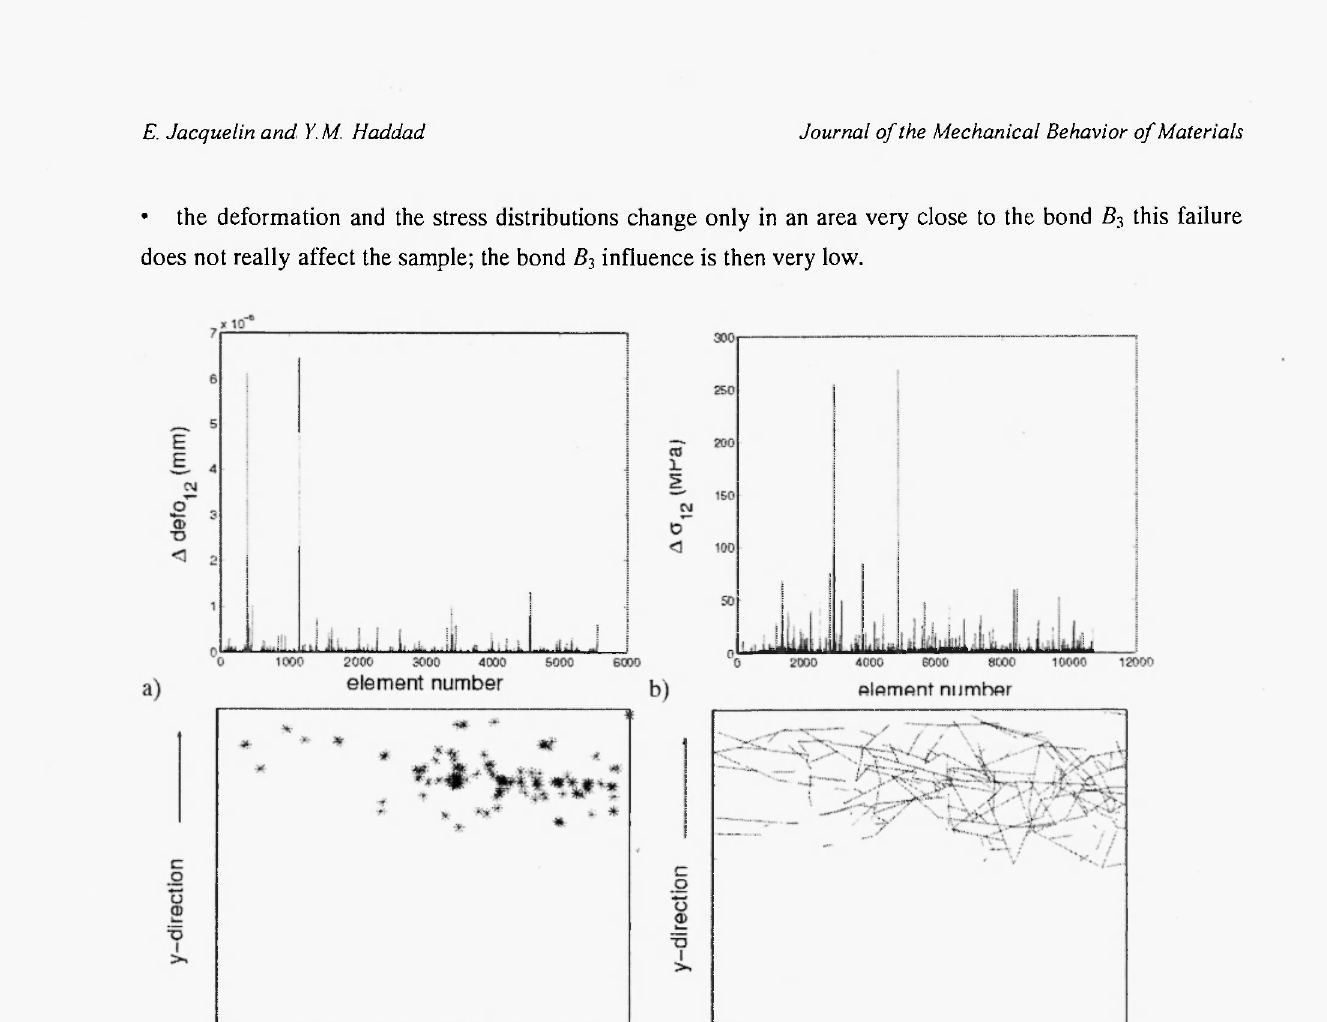
Fig. 1 1: Actual broken bond influence: a) bond deformation difference - b) element stress difference - c) influenced bonds - d) influenced